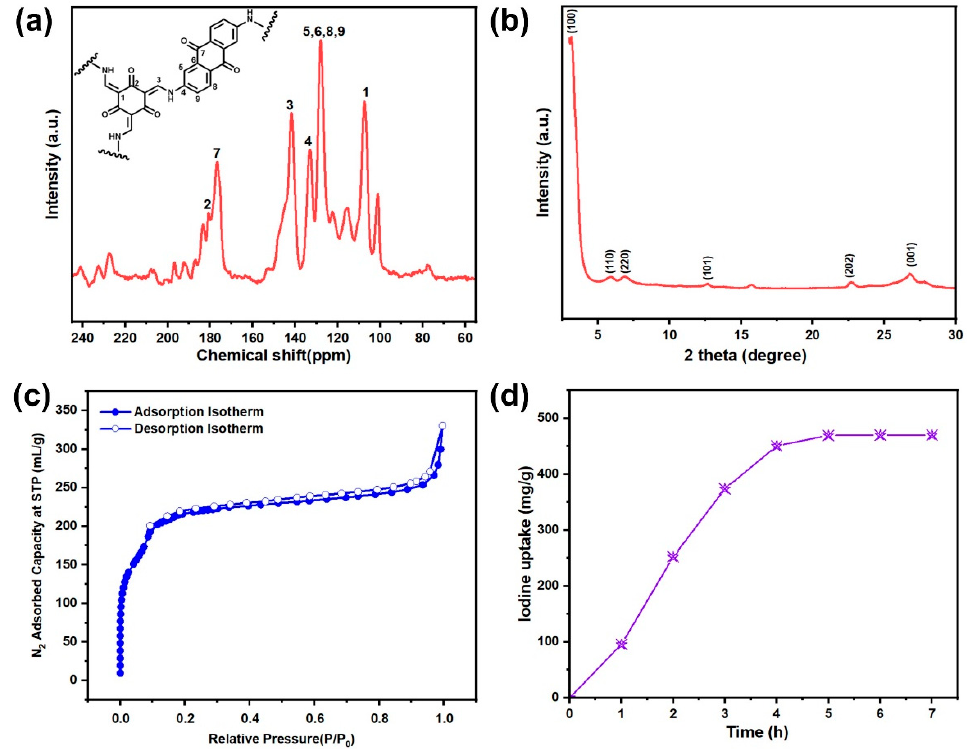
Figure 1. ( a ) 13 C solid-state NMR spectrum of the AQ-COF, ( b ) PXRD patterns of the AQ-COF, ( c ) N 2 physisorption isotherms for the AQ-COF at liquid nitrogen temperature, and ( d ) iodine uptake of the AQ-COF at 70 °C.